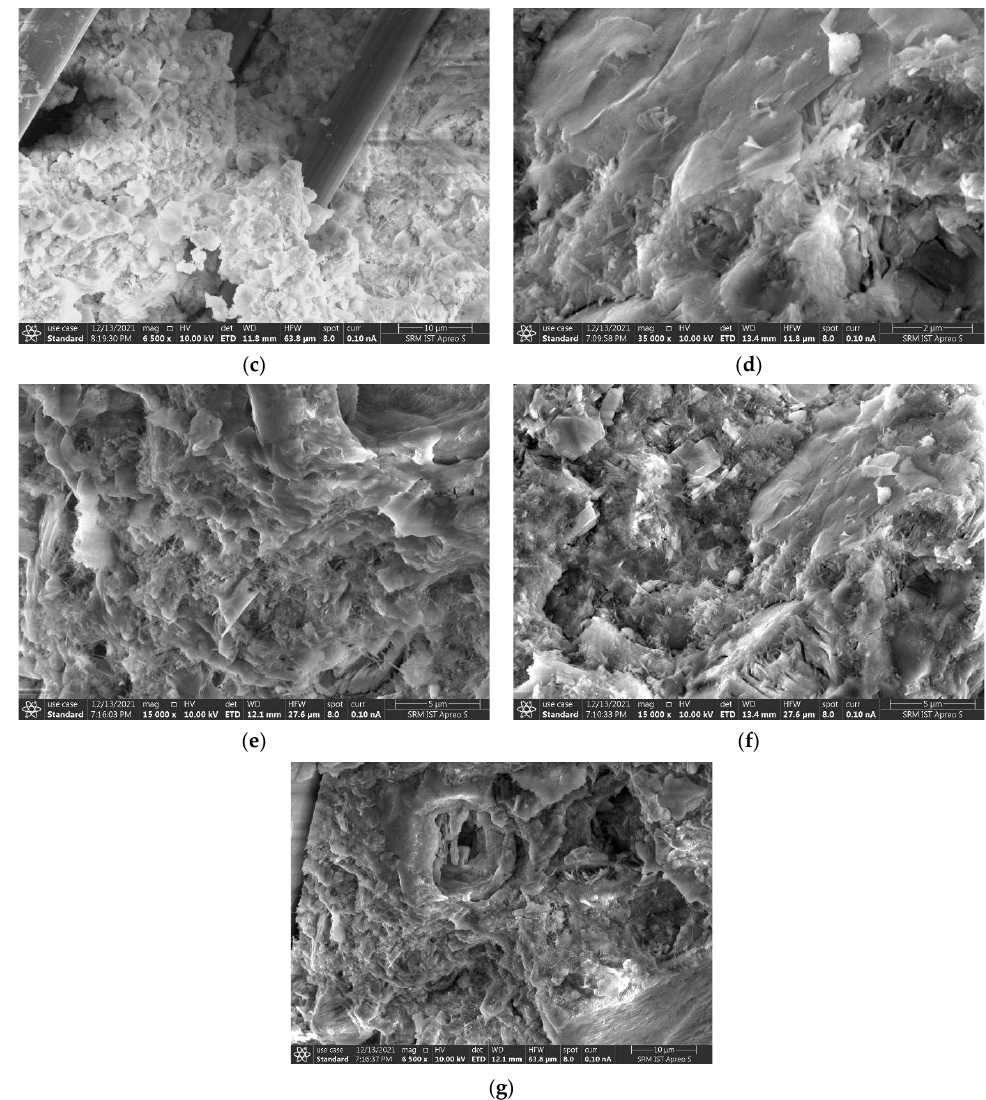
Figure 15. SEM Images: ( a ) Conventional Concrete, ( b ) Steel fibre reinforced concrete, ( c ) Carbon fibre reinforced concrete, ( d ) Glass fibre reinforced concrete, ( e ) Coir fibre reinforced concrete, ( f ) Jute fibre reinforced concrete, ( g ) Sisal fibre reinforced concrete.